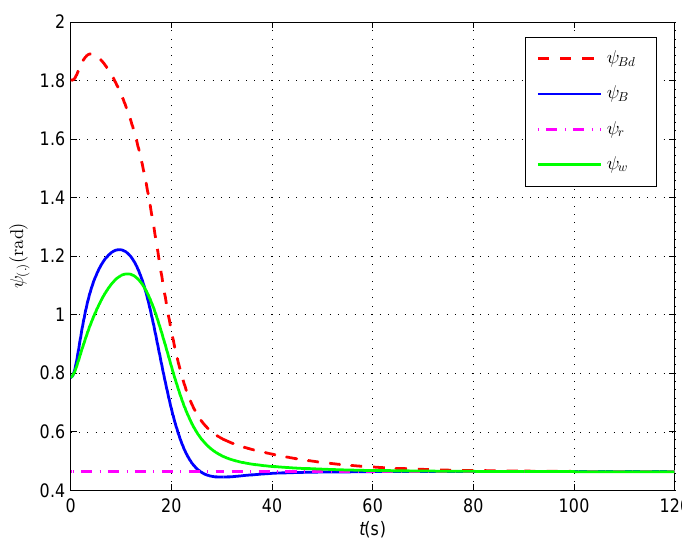
Figure 10. The red dashed line, the blue line and the green line represent the desired yaw angle, the actual yaw angle and the course angle of the AUV, respectively, and the pink dash dotted line represents the orientation angle of the cable.